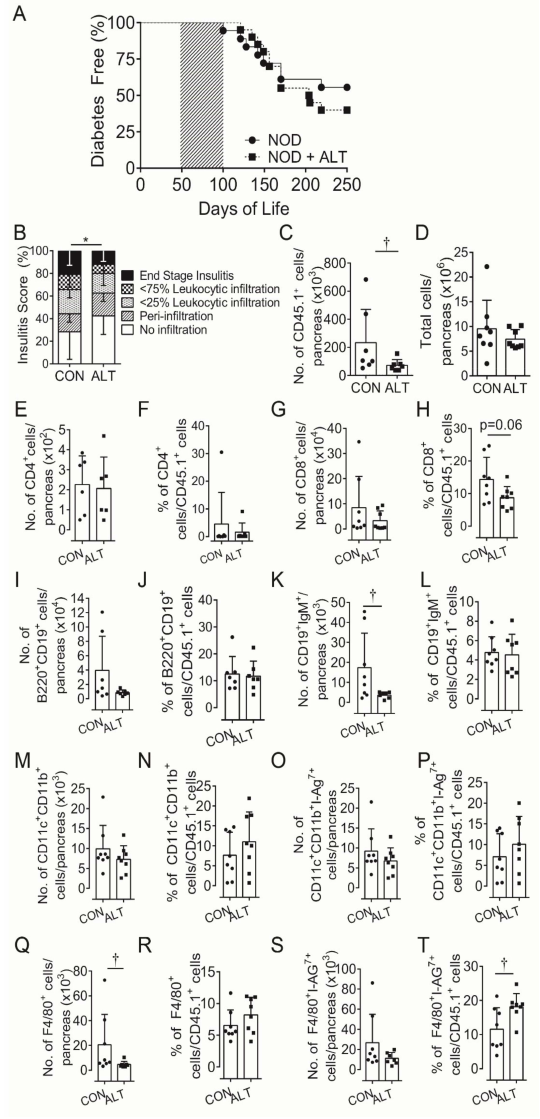
Figure 1. Short term AGE lowering therapy pre-diabetes in NOD mice does not protect against dia- betes development despite attenuating β -cell infiltration. ( A ) Diabetes incidence of female NOD ShiLt (NOD) mice ( n = 18–20/group) from day 50 to 100 of life (shaded grey) were untreated (NOD, • ) or treated with the AGE lowering therapy alagebrium chloride (ALT, 1 mg/kg/day, s.c; (cid:4) ). Mice were monitored daily, blood glucose tested weekly for diabetes incidence and mice were euthanised when either blood glucose concentrations exceeded 15 mmol/L for two consecutive days, day 250 of life was reached without diabetes diagnosis. ( B ) Islet immune cell infiltration at day 90 of life shown